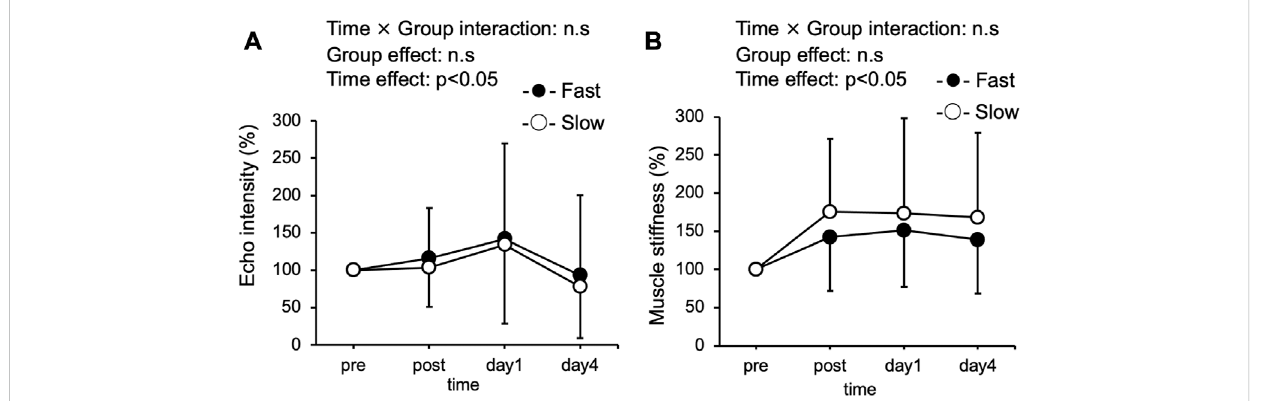
FIGURE 4 Changes (mean ± SD) in echo intensity of the quadriceps (A) , and muscle stiffness of the knee extensor (vastus laterials, rectus femoris, and vastus medialis) (B) , before (pre), immediately after (post), 1 day, and 4 days after eccentric muscle actions in the slow velocity session (Slow) and fast velocity session